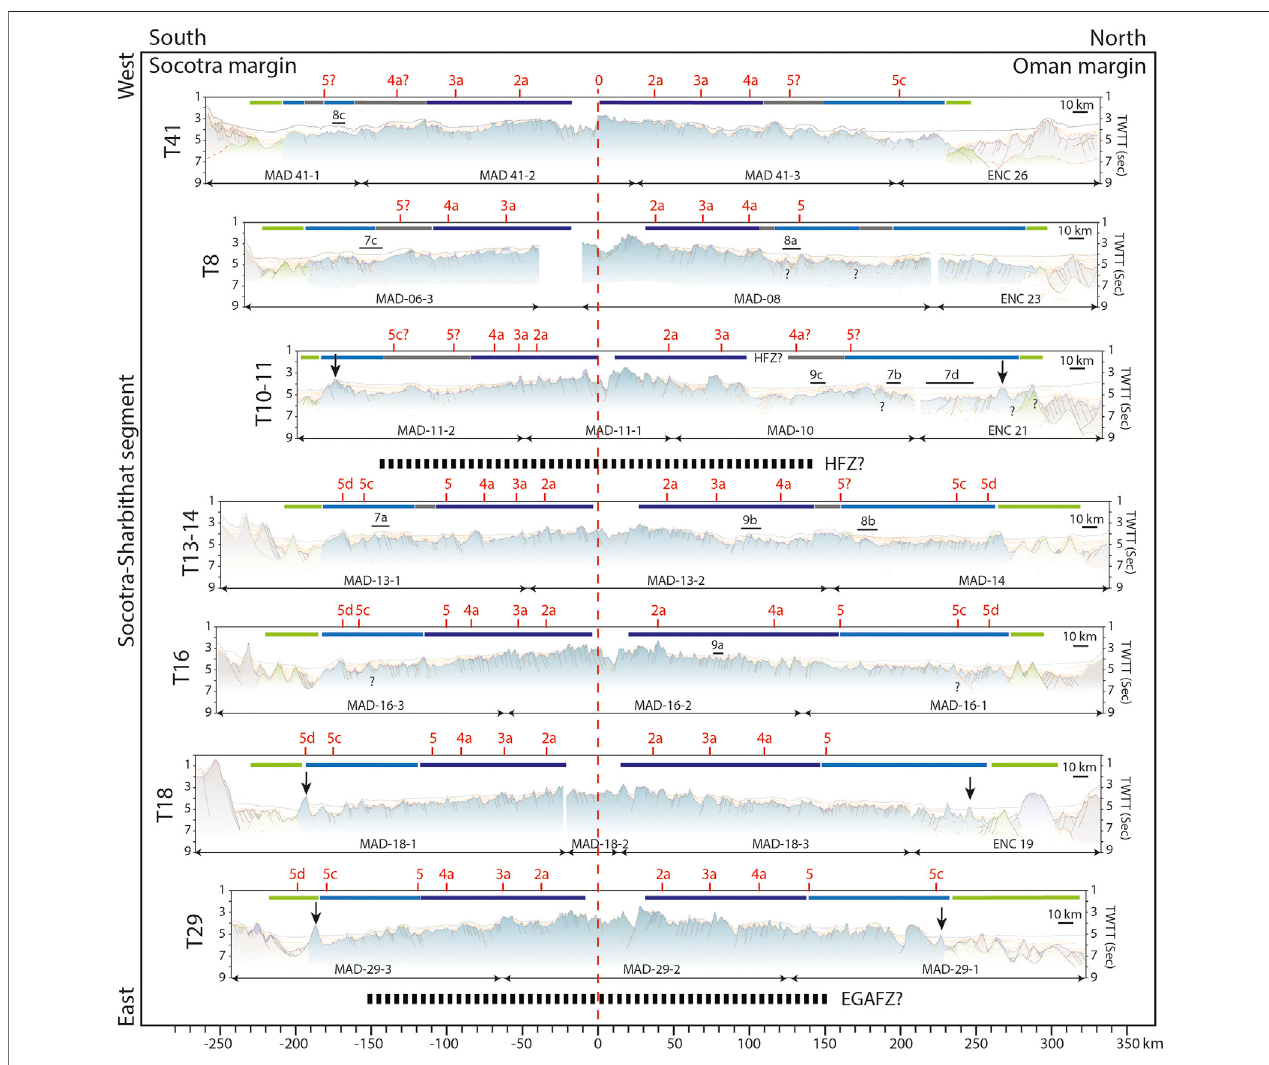
FIGURE 2 | Interpreted seismic transects along the Socotra-Sharbithat segment, in two-ways travel time (TWTT, seconds). Transects T21 and T27 are too noisy and not displayed. The transects are aligned on the magnetic anomaly 0 (ridge axis). The other interpreted magnetic anomalies are displayed in red. In green the OCT domain, in light blue the old oceanic domain (in grey the smooth and regular basement subdomain), in dark blue the young oceanic domain. Black arrays locate the basementridgeassociatedwiththeendoftheOCT/ fi rstoceaniccrust.Closeuplocationsshownin Figures6 , 7 , 8 areindicatedby fi gurenumberoneachtransect. The dashed dark lines between transects represent the fracture zones (HFZ: Hadibo Fracture Zone, EGAFZ: Eastern Gulf of Aden Fracture Zone).